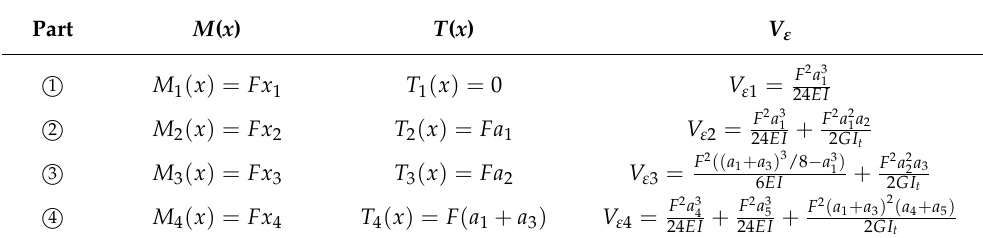
Table 1. M ( x ), T ( x ) and V ε of equivalent mechanical spring structure.